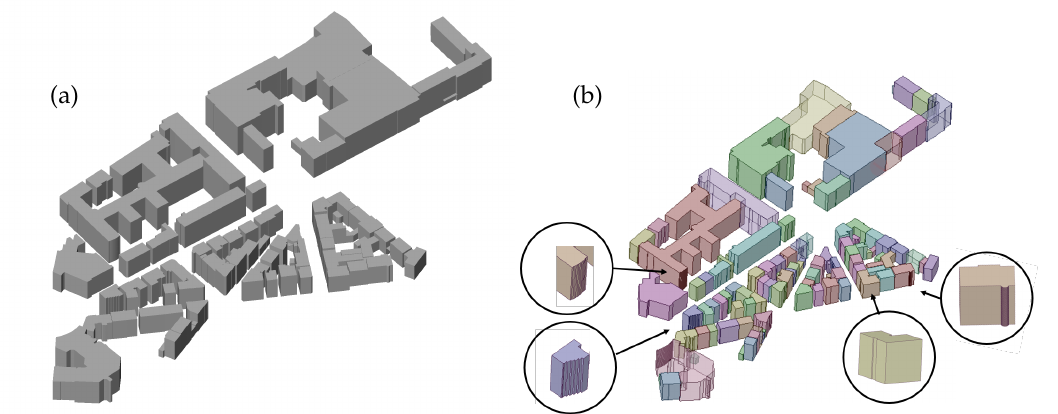
Figure 3. Buildings considered in the CFD simulation: ( a ) original CityGML, ( b ) buildings converted to STEP. The model contains details which make the mesh generation for CFD simulations difficult or even impossible.